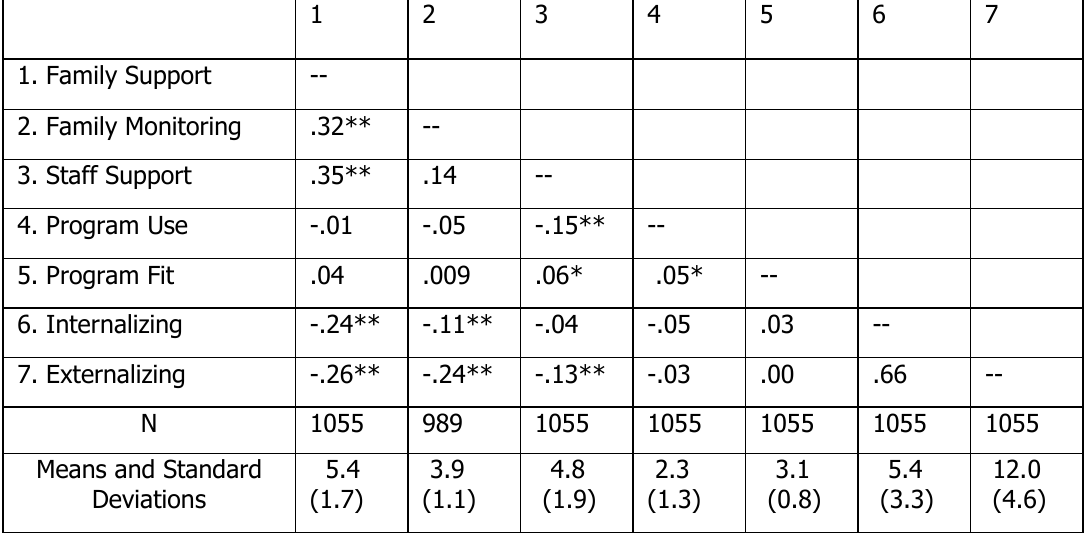
Intercorrelations of Independent (Family, Program) and Dependent (Youth Adjustment)